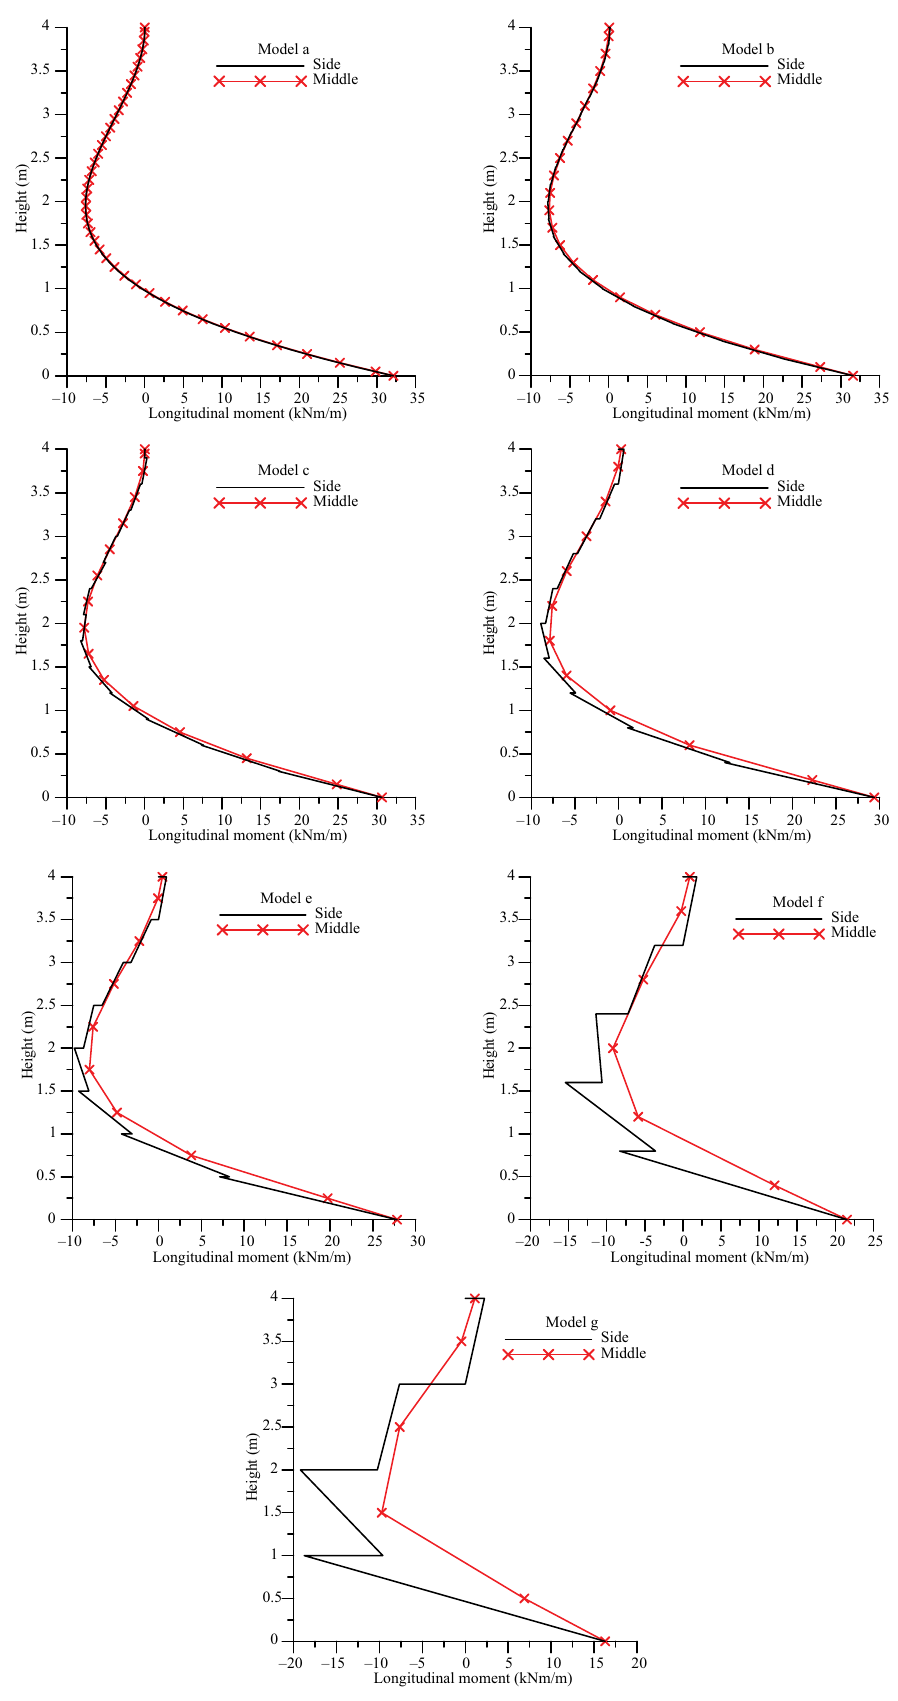
Fig. 6. FEM models longitudinal moments of middle and side of the